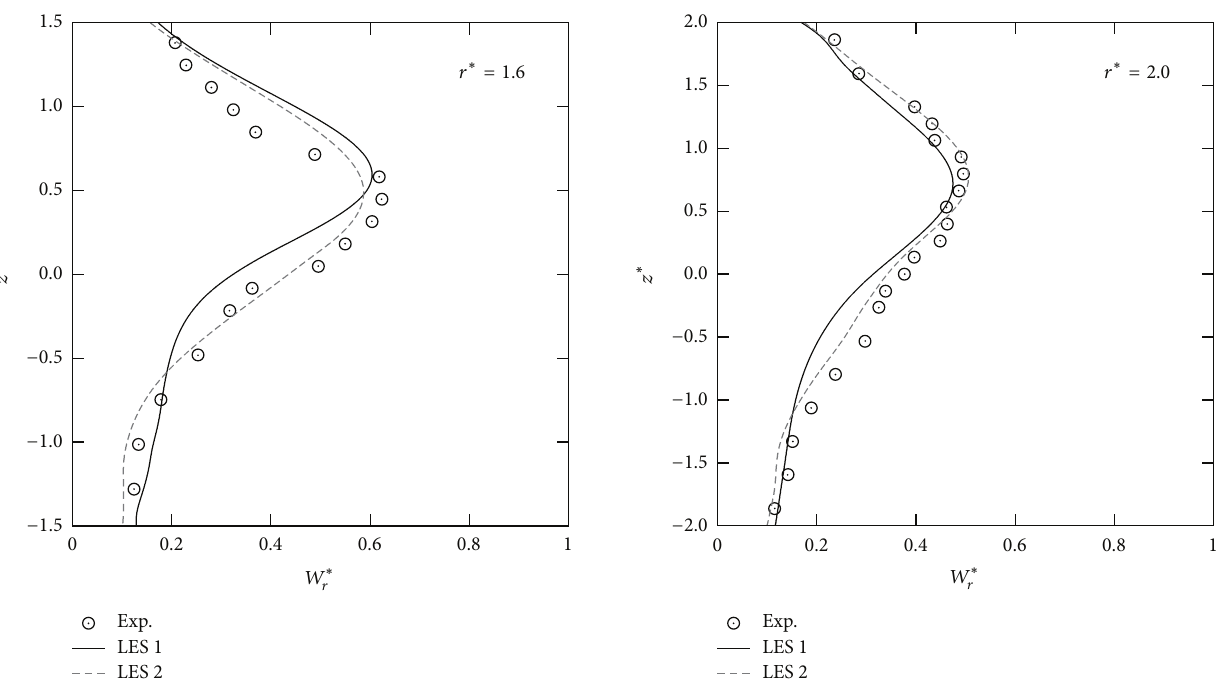
Figure 10: Radial component of the ensemble-averaged mean velocity at 𝑟 ∗ = 2.0